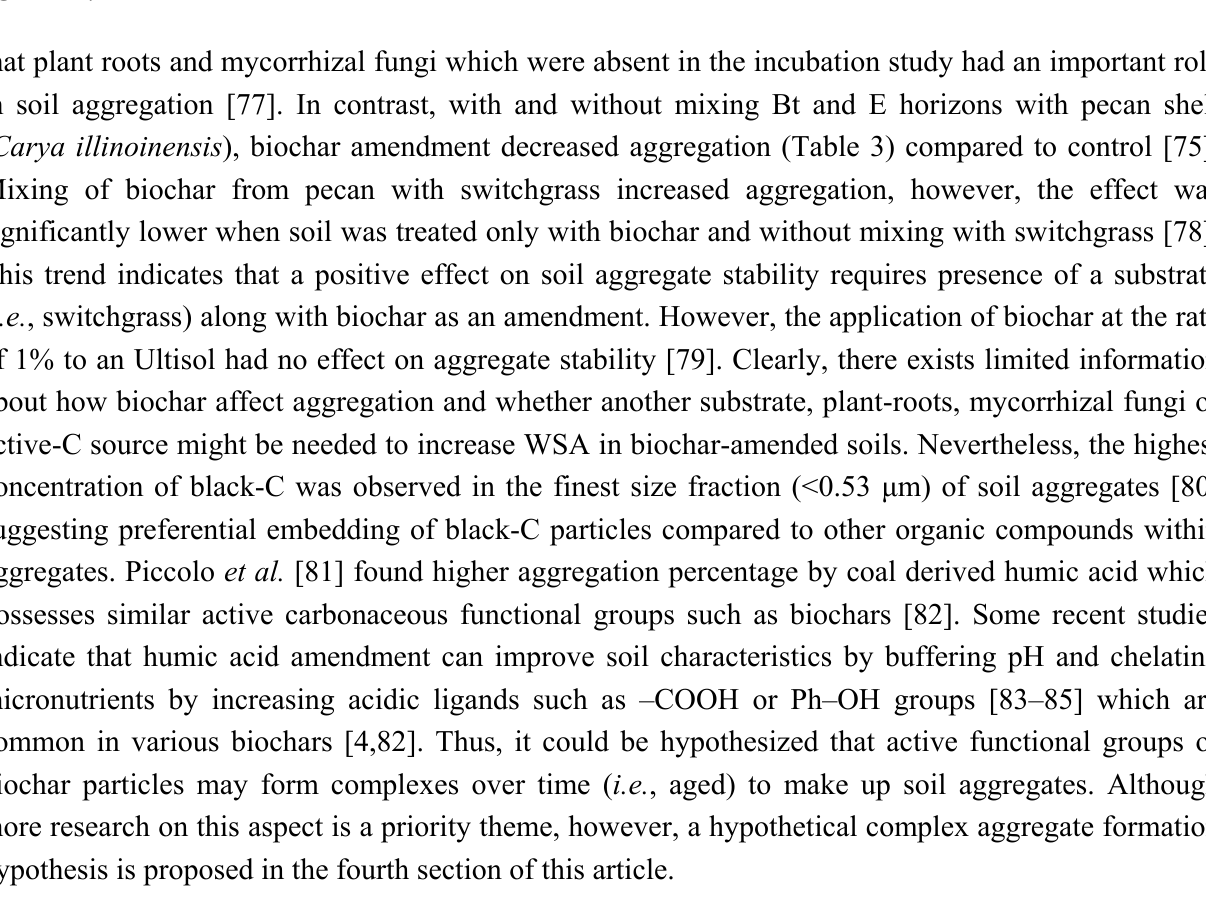
Table 3. Impact of biochar on aggregation and penetration